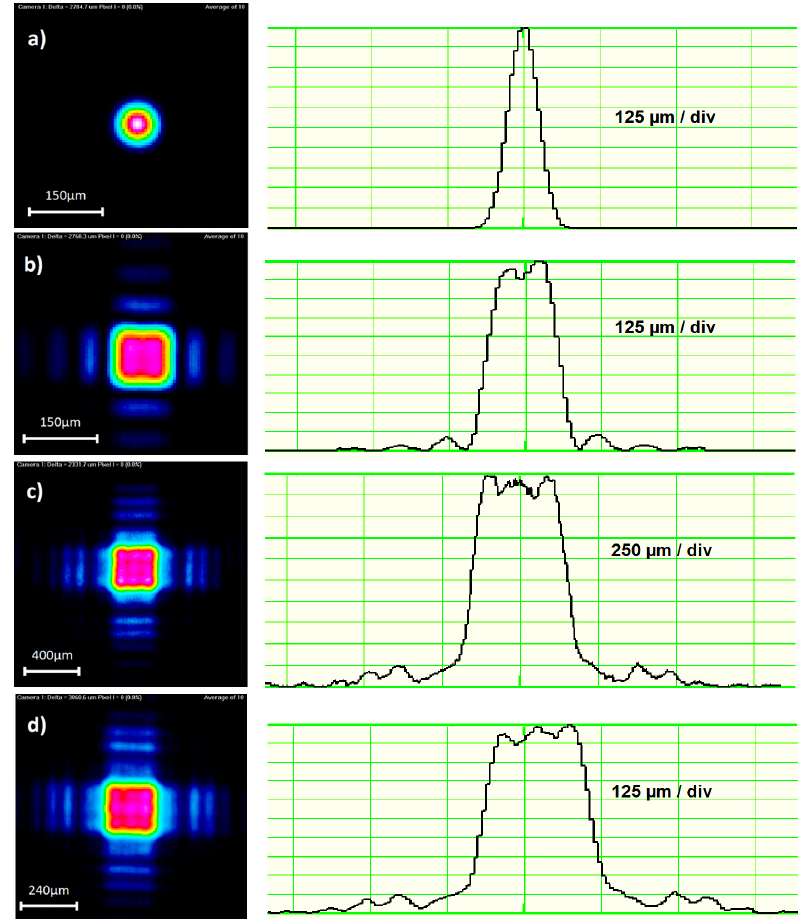
Figure 9. Measurement of generated beam profiles ( a ) Focused Gaussian profile at beam waist; ( b ) zero-order Top-Hat profile; ( c ) − 1 order Top-Hat profile; ( d ) + 1 order Top-Hat profile.